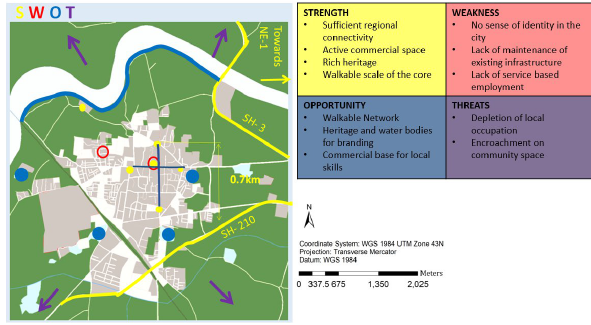
Figure 7. a) SWOT Analysis on Mehmedabad b) Key points